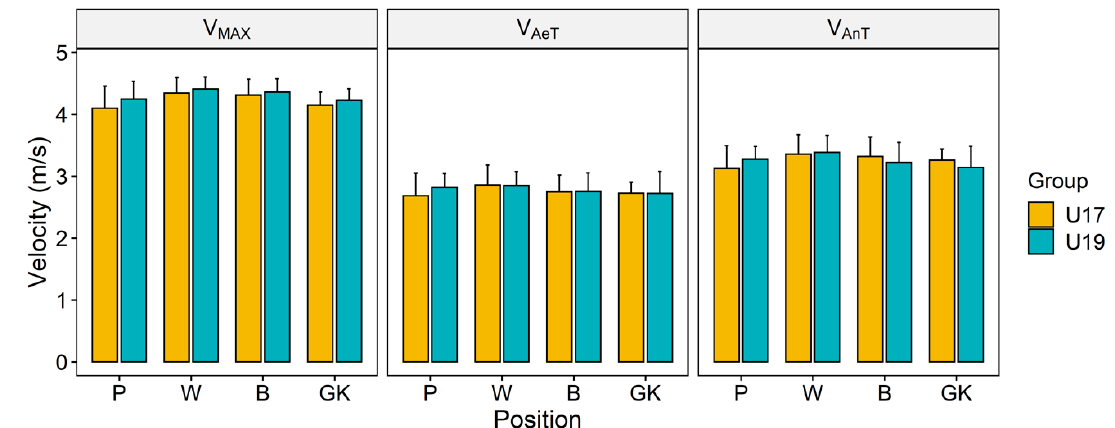
Figure 2. Velocity of the players at three intensity zones.